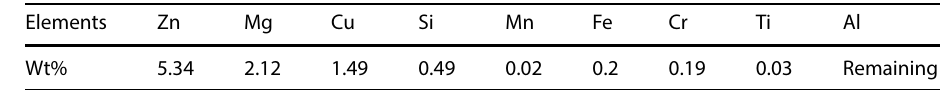
Table 2 Chemical composition of hybrid Al 7075/B